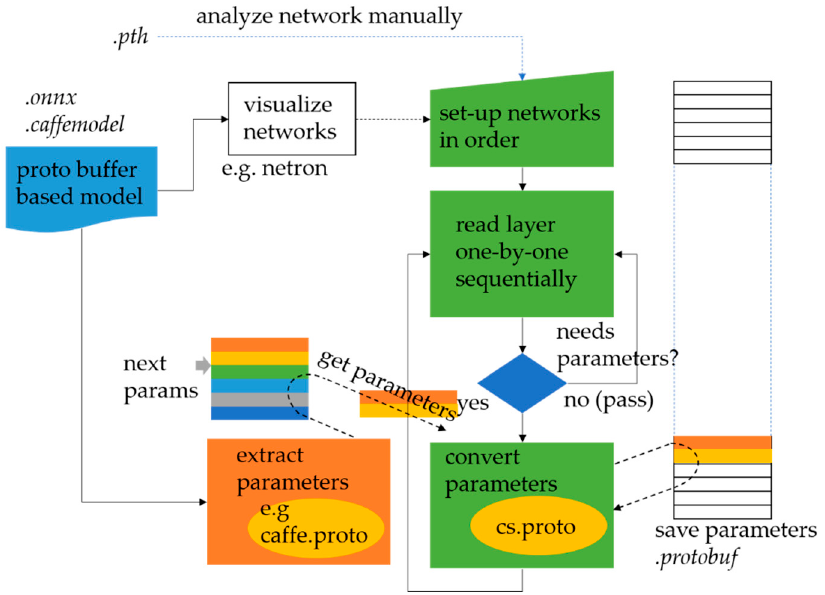
Figure 8. Model conversion process of our framework.